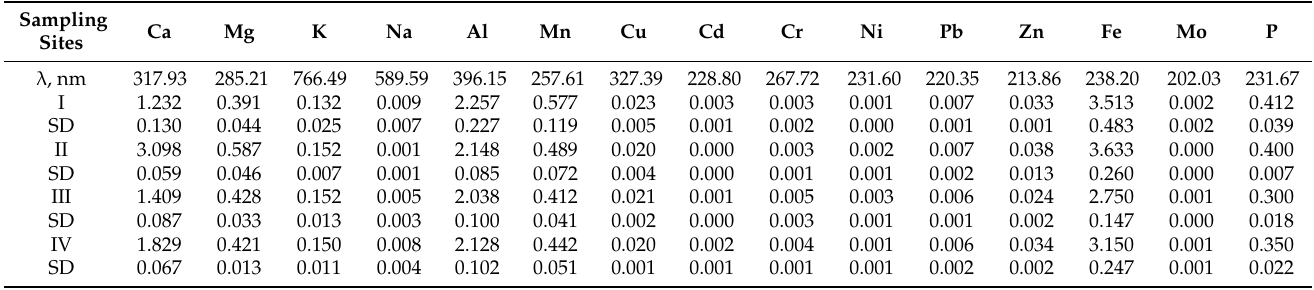
Table 2. Main elements (weight %, n = 3, standard deviation (SD)) in the soil (four different sampling sites, I–IV) of Solidago spp. growing